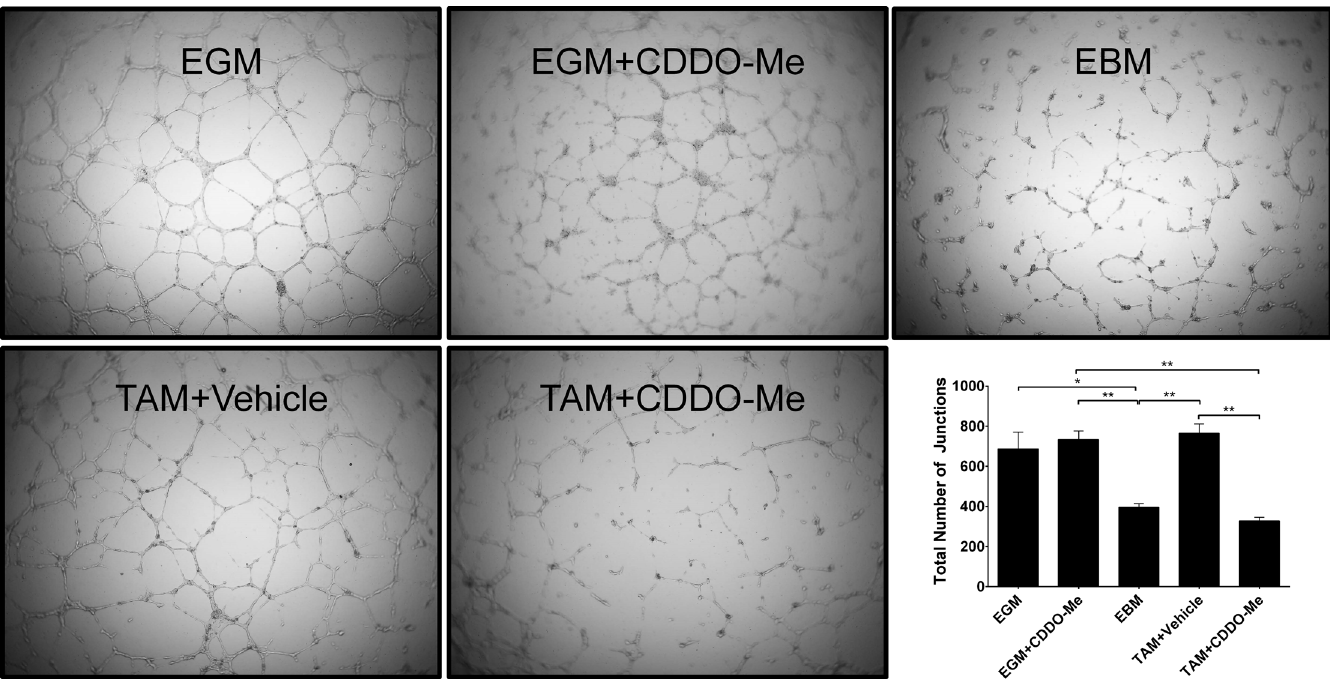
Fig 5. Altered TAM polarization by CDDO-Me inhibits EC vessel formation. F4/80+ tumor associated macrophages (TAMs) were isolated from the tumors of 12-week old female PyMT mice and treated in vitro with DMSO control or CDDO-Me (300 nM) for 16 hrs. Conditioned media (CM) were collected from TAM cultures. ECs were cultured on basement membrane extract in the presence of complete endothelial growth media (EGM; top left), endothelial basal media (EBM; top right), endothelial growth media in the presence of CDDO-Me (EGM+CDDO-Me; top center) vehicle-treated TAM CM (TAM+Vehicle, bottom left), or CDDO-Me treated TAM CM (TAM+CDDO-Me, bottom center). Total number of junctions was quantified by AngioTool software and is represented in the bottom right panel. Data are representative of 2 independent experiments. * p < 0.05, ** p < 0.01. Quantification represents mean ± standard